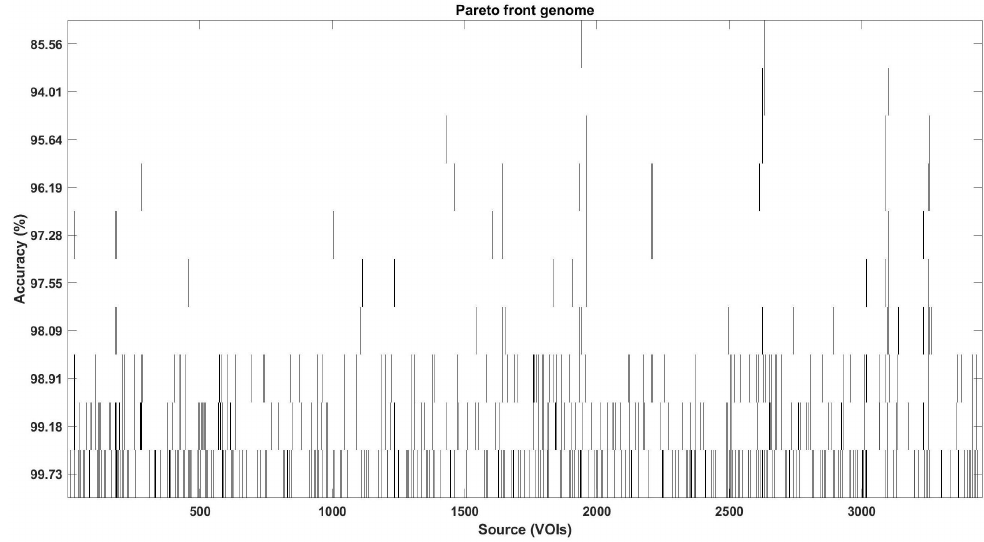
Figure 11. Pareto front genome, where the VOIs that are most relevant to obtain a high accuracy in the classifier, are highlighted.